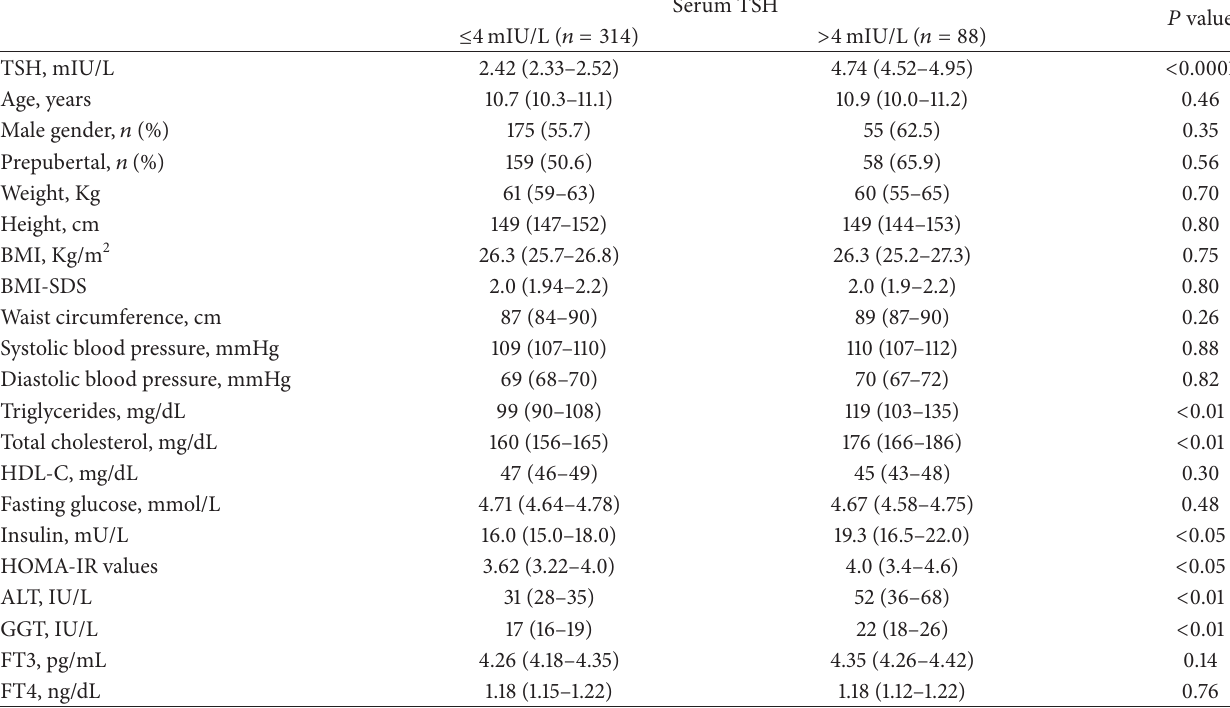
Table 1: Baseline characteristics of 402 overweight/obese children according to serum